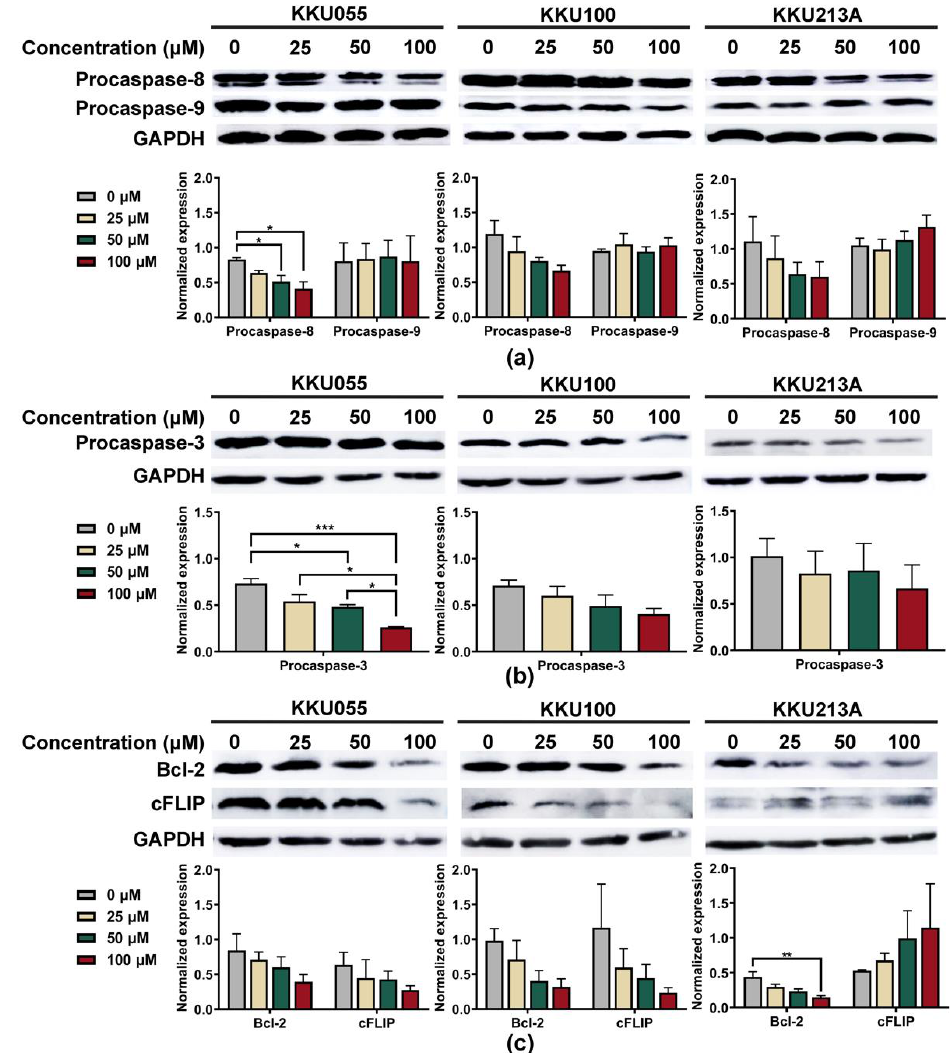
Figure 4. Genistein induced apoptosis through an extrinsic pathway in CCA cell lines. The im- munoblotting technique was used to examine the alterations of apoptotic marker proteins, including ( a ) procaspase-8 and procaspase-9, and ( b ) procaspase-3 after 24-h treatment of genistein at the concentration of 25, 50, and 100 µ M in KKU055, KKU100, and KKU213A cells. The changes in anti-apoptotic proteins: ( c ) Bcl-2 and cFLIP proteins, were also detected. Band intensity representing protein quantity was normalized with that of GAPDH. The statistical differences were tested by comparing to the value of diluent control (* indicates p < 0.05, ** indicates p < 0.01, and *** indicates p < 0.001).